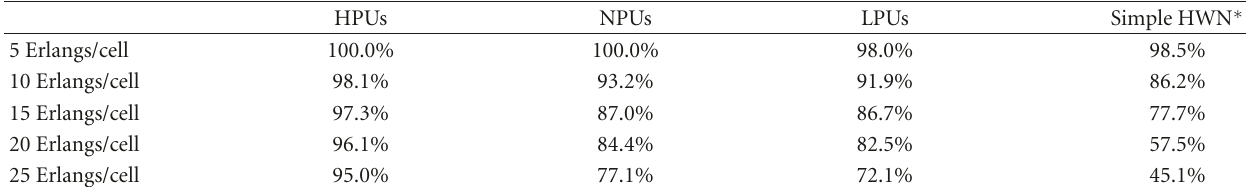
Table 3: Success route acquire ratio comparison between di ff erent user classes.